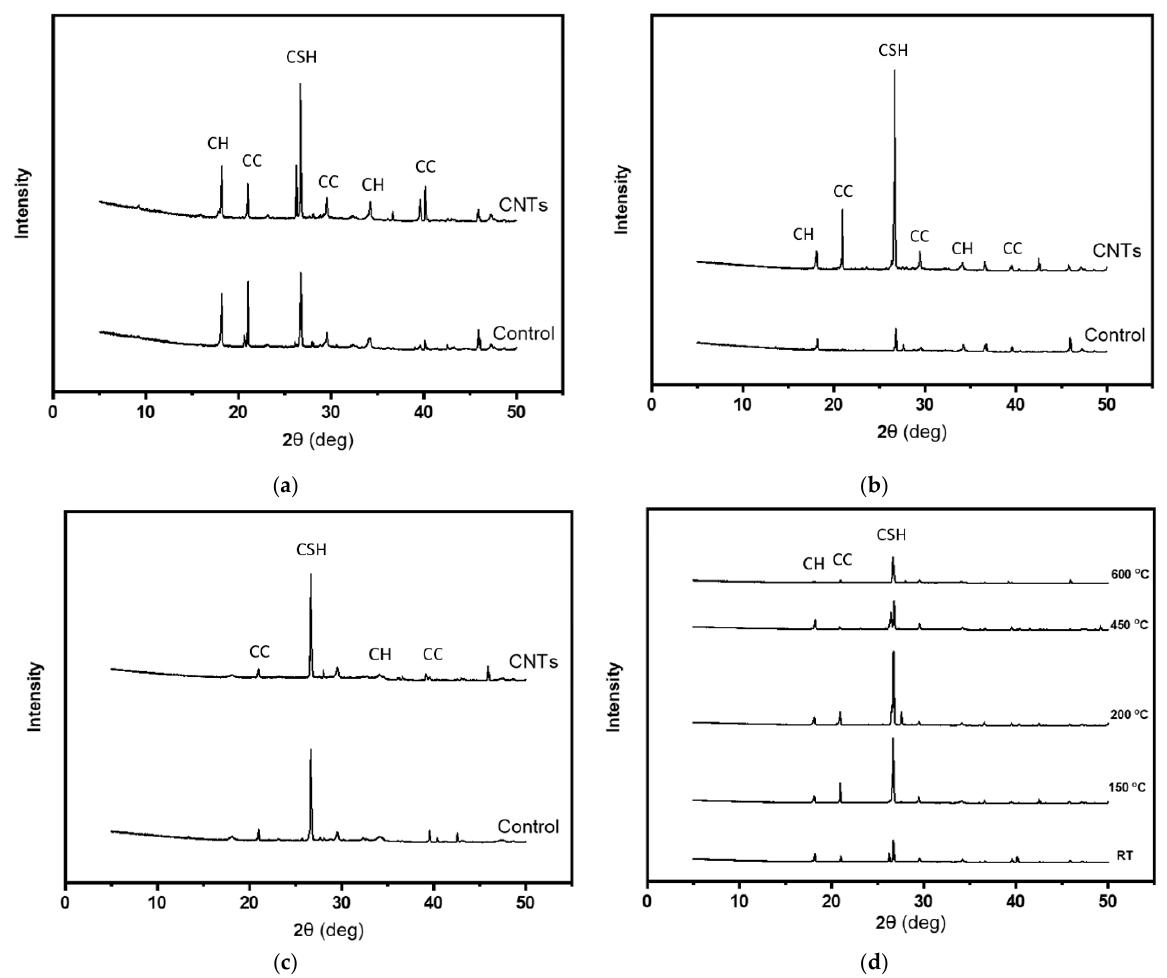
Figure 2. XRD patterns for plain and CNT-reinforced mortar heated at ( a ) RT; ( b ) 200 ◦ C; ( c ) 450 ◦ C; and ( d ) XRD patterns of CNT-reinforced mortar heated at various temperatures.